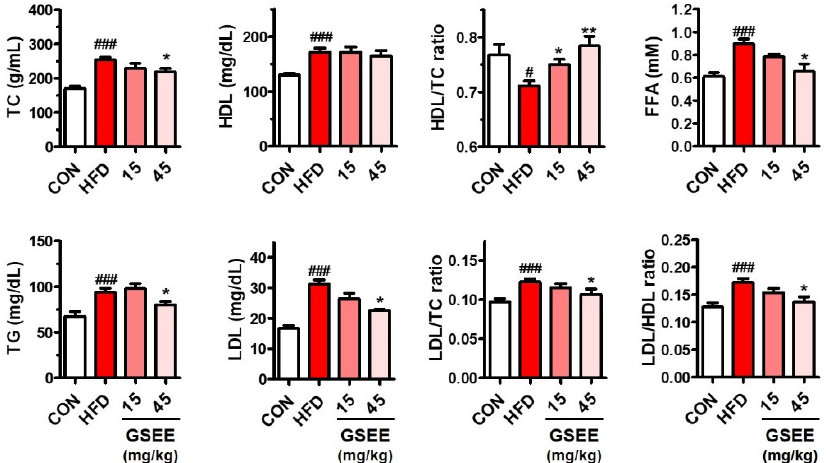
Figure 3. E ff ects of the GSEE on serum lipid markers in HFD-fed obese mice. Mice ( n = 8 in each group) were fed with HFD for 10 weeks with or without daily oral administration of GSEE (15 or 45 mg / kg of body weight). Values are represented as mean ± SE. Student’s t -test, ### p < 0.001 vs. control. *, ** p < 0.05, and 0.01, respectively, vs. HFD. TC, total cholesterol; TG, triglyceride; HDL; high-density